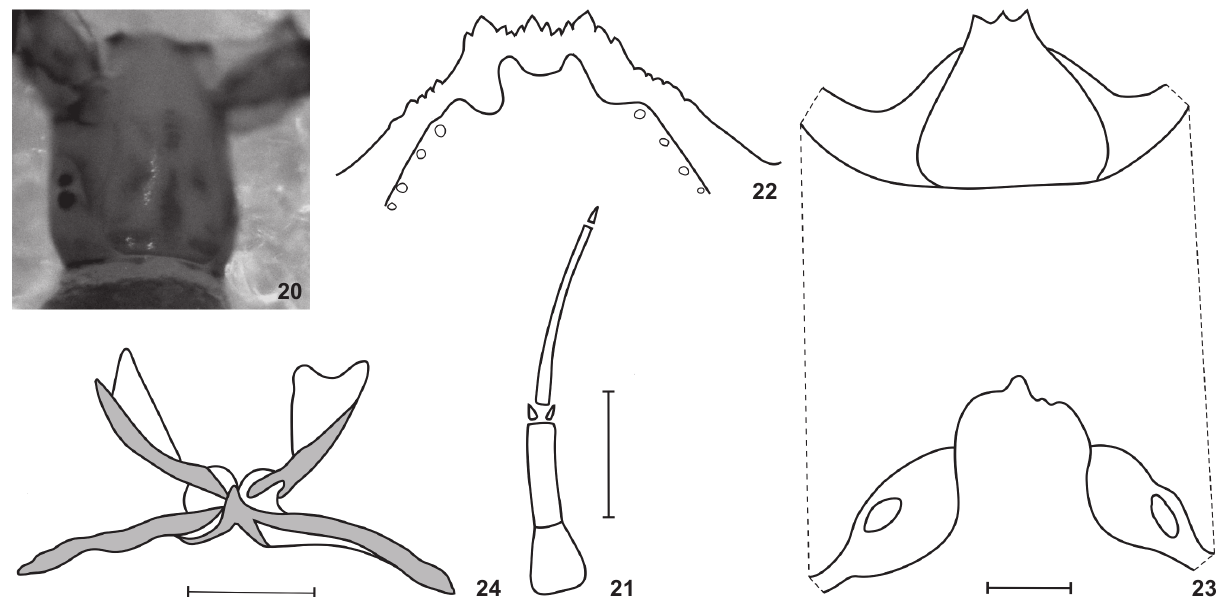
Figure 20-24. Larva of L. flavopubescens : (20) head capsule, dorsal view; (21) antenna; (22) hypostomal teeth; (23) head capsule, ventral view; (24) anal sclerite. Bar: 0.1